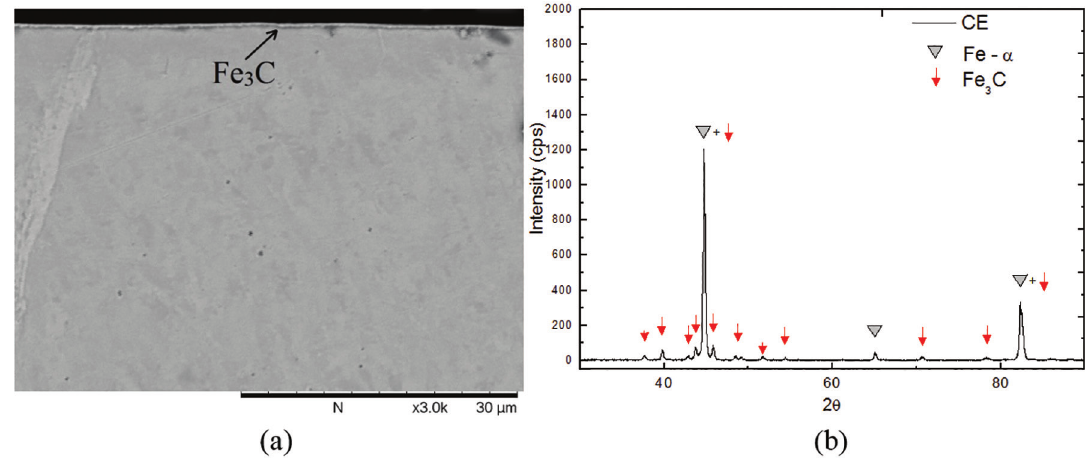
Figure 2: Sample CE: (a) scanning electron microscopy and (b)